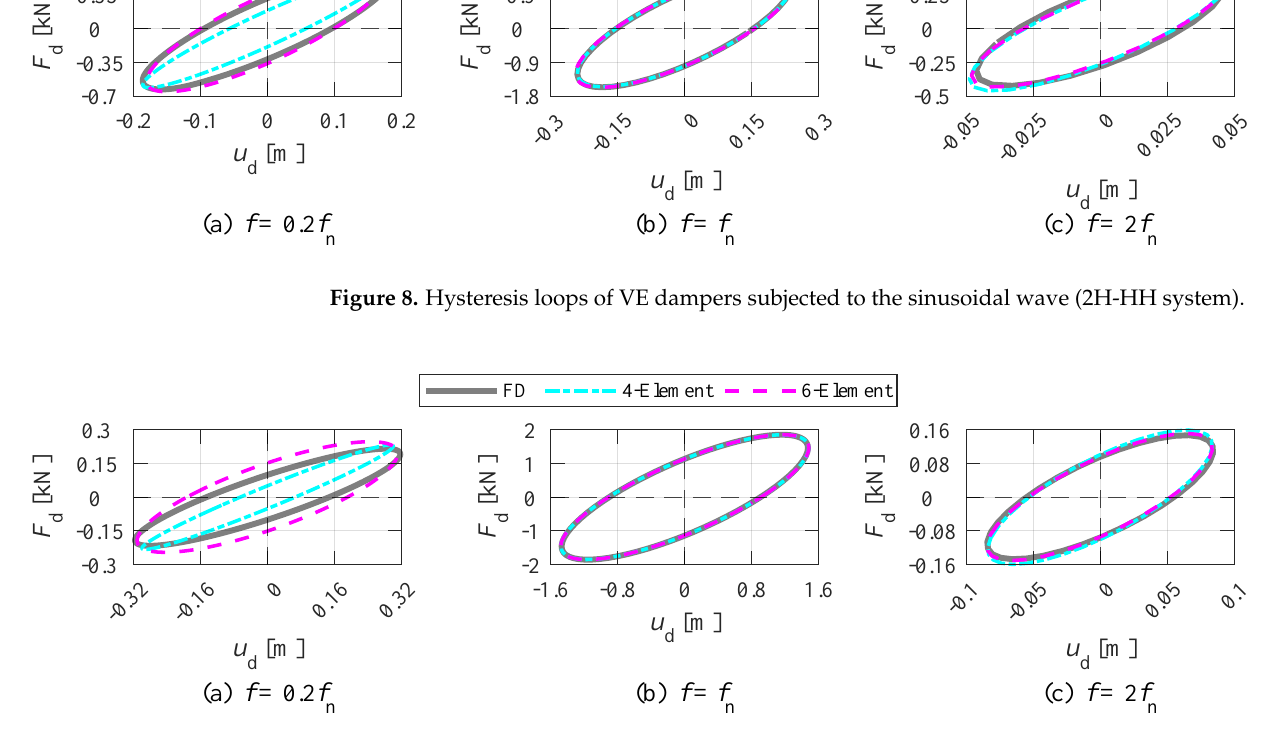
Figure 9. Hysteresis loops of VE dampers subjected to the sinusoidal wave (2H-SS